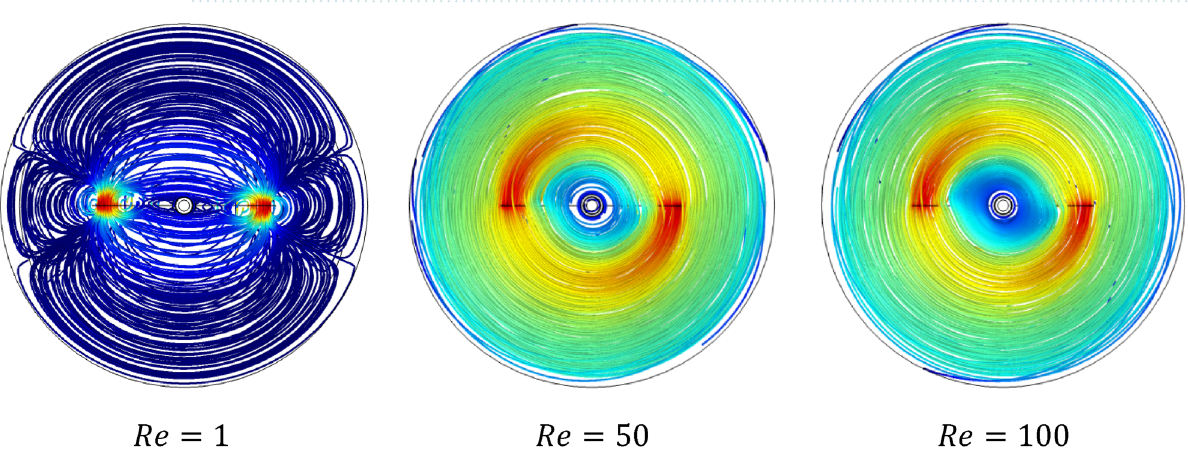
Figure 18. 2D streamline distribution along stirred vessel for Bn = 50 with inertia variation value.